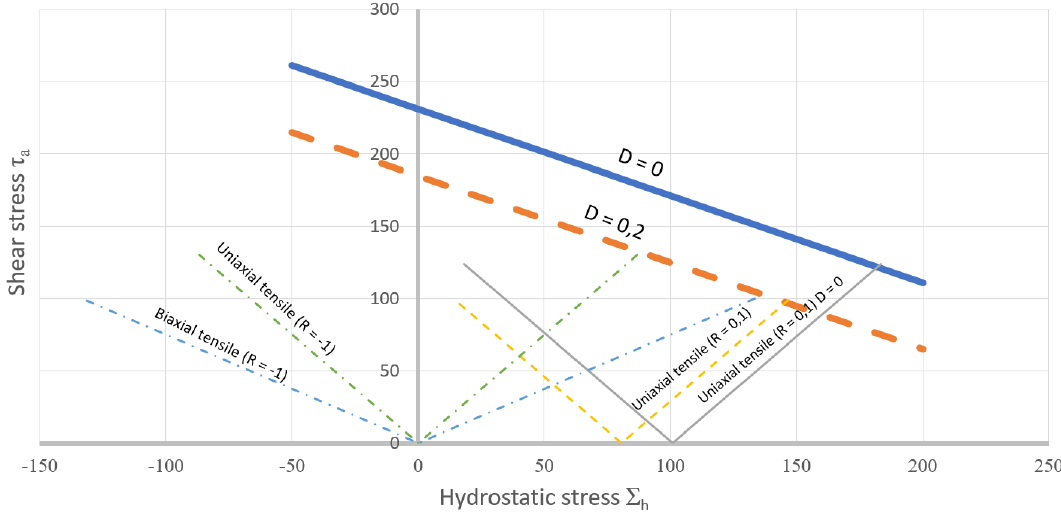
Figure 14. Dang Van diagram with predictions of fatigue limit for different loadings.